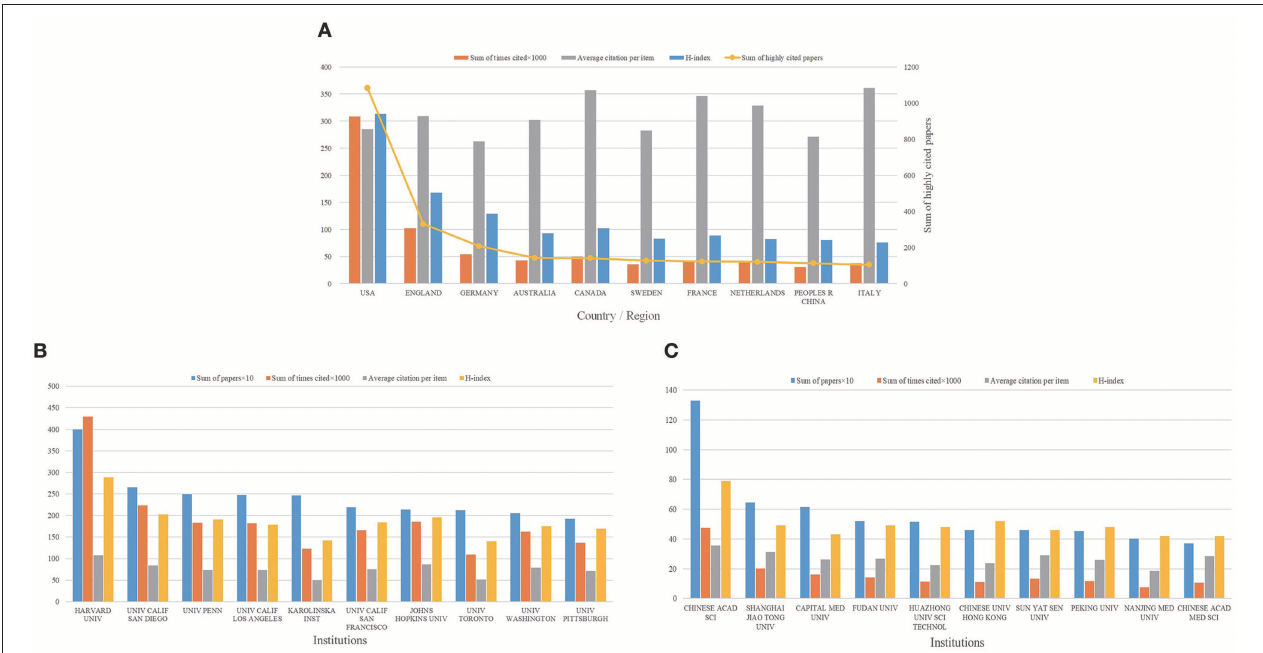
FIGURE 2 | Citation and h-index analyses globally and in China. (A) Total citations, average citations per article, and h-index for AD articles from the top 10 countries. (B) Total citations, average citations per article, and h-index for AD articles from the top 10 global institutions by publication volume. (C) Total citations, average citations per articles, and h-index for AD articles from the top 10 Chinese institutions by publication volume.